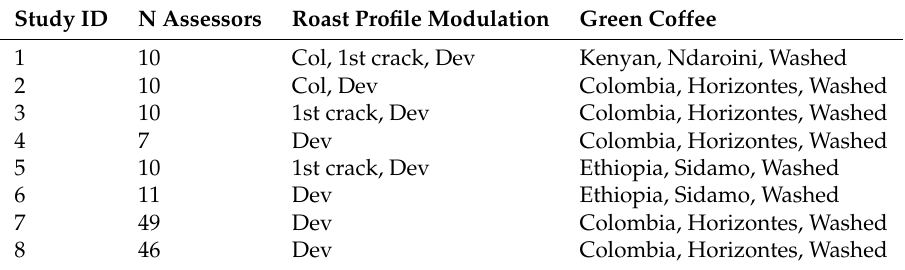
Table 1. Overview of the studies included in the paper. The third column indicates which part of the roasting process was varied in each individual study (Col = roast colour, 1st crack = time to first crack, Dev = development time). The sensory profiling data from Study 1 were previously published in [26].